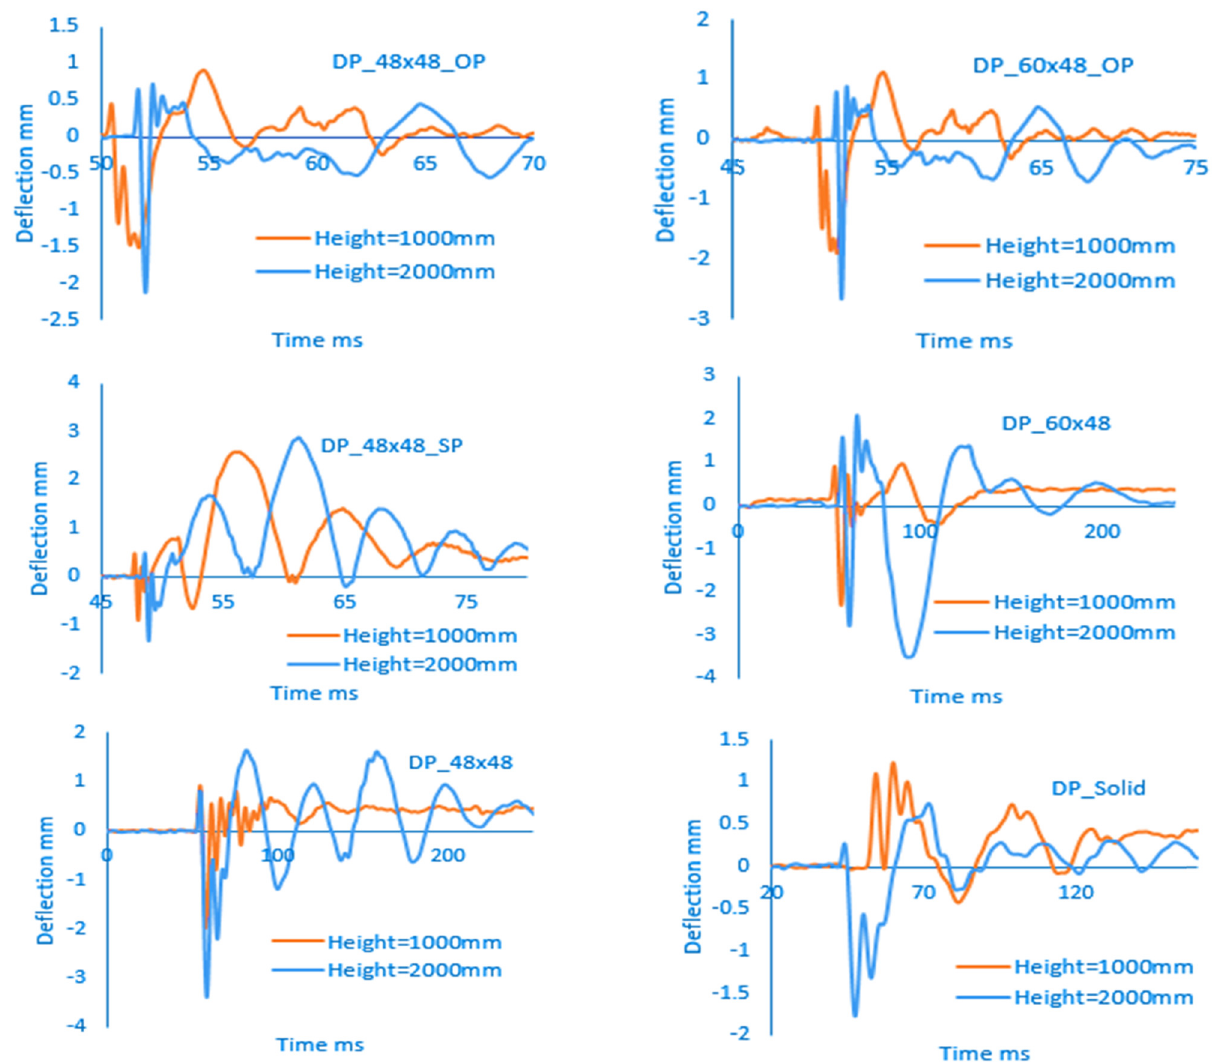
Figure 6: Transient de fl ection – time histories for tested